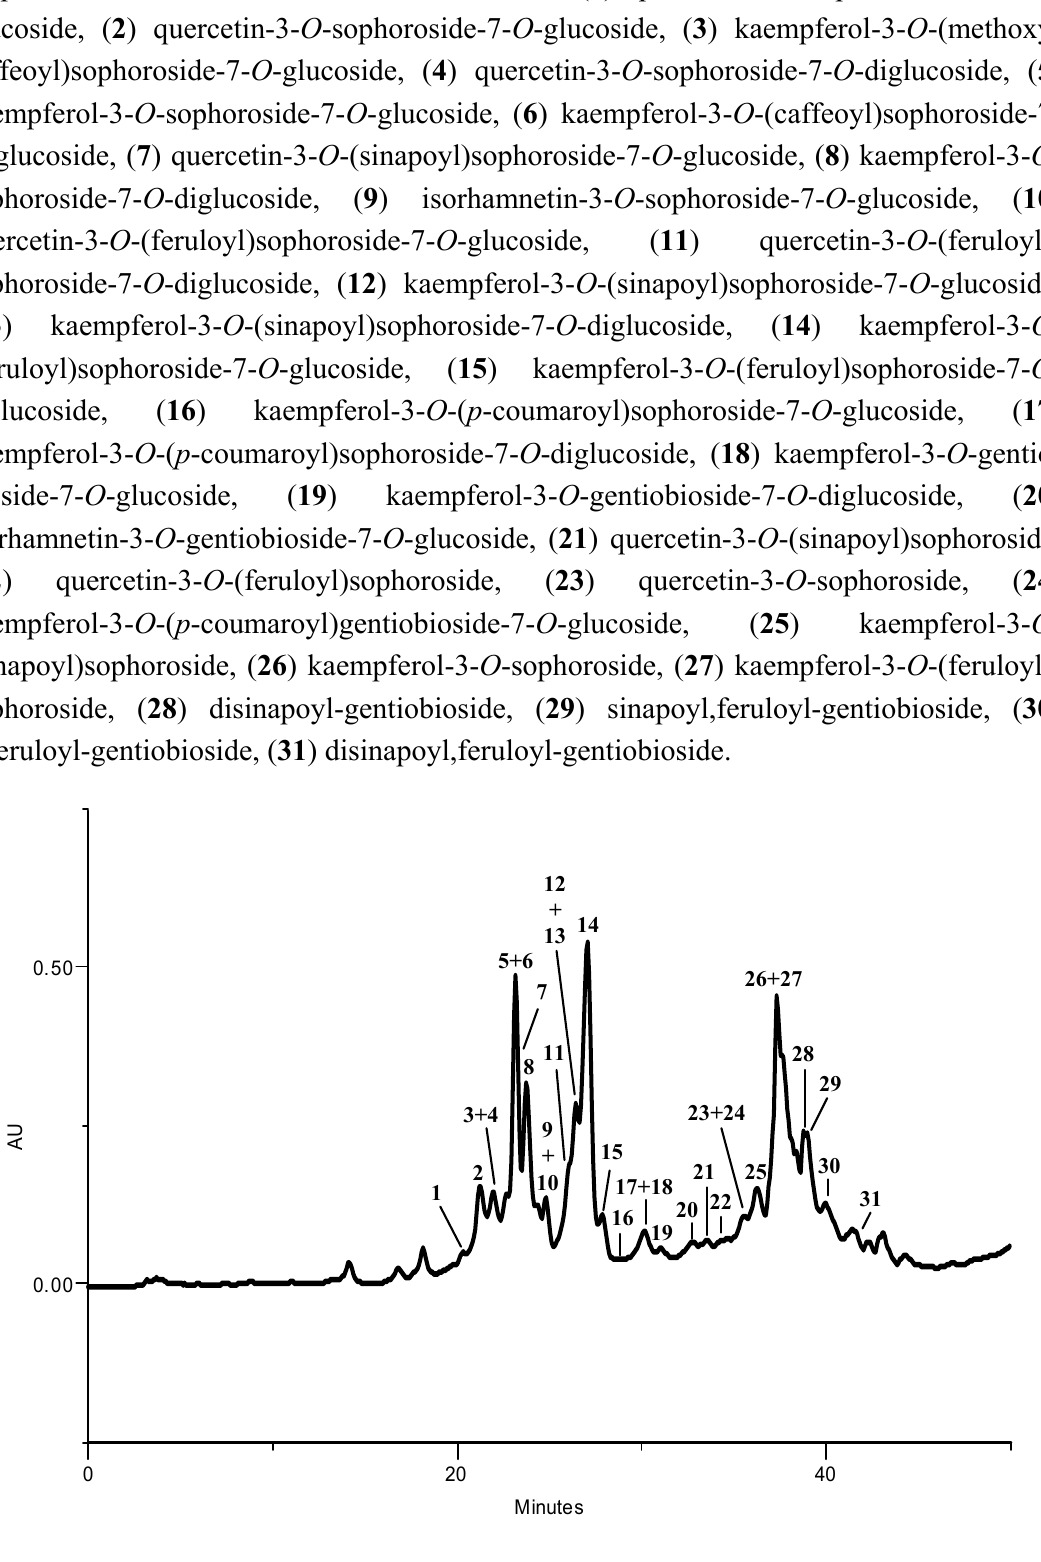
Figure 2. HPLC-DAD phenolic profile of the methanolic extract of B. oleracea var. acephala leaves. Detection at 330 nm. Peaks: ( 1 ) quercetin-3- O -sophorotrioside-7- O - glucoside, ( 2 ) quercetin-3- O -sophoroside-7- O -glucoside, ( 3 ) kaempferol-3- O -(methoxy- caffeoyl)sophoroside-7- O -glucoside, ( 4 ) quercetin-3- O -sophoroside-7- O -diglucoside, ( 5 ) kaempferol-3- O -sophoroside-7- O -glucoside, ( 6 ) kaempferol-3- O -(caffeoyl)sophoroside-7- O -glucoside, ( 7 ) quercetin-3- O -(sinapoyl)sophoroside-7- O -glucoside, ( 8 ) kaempferol-3- O